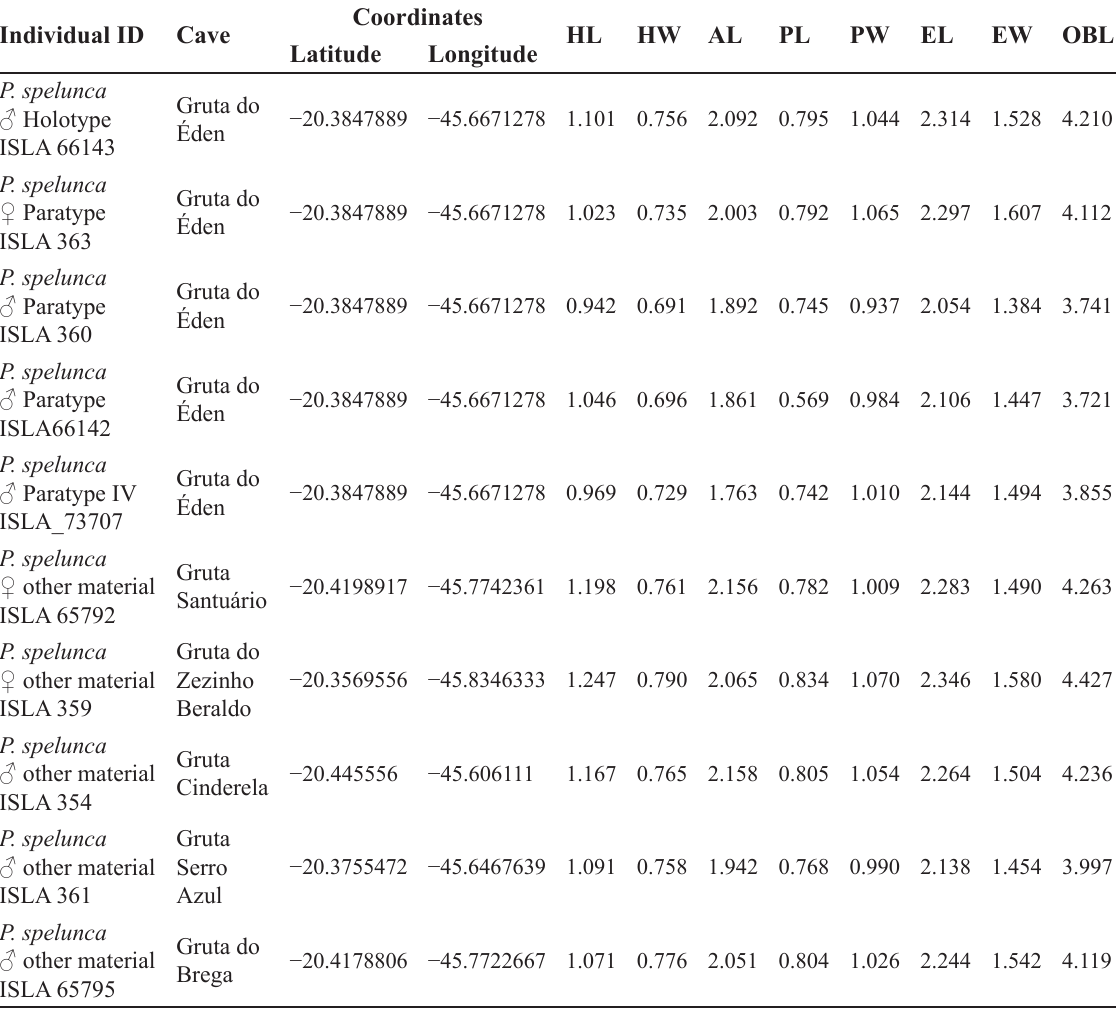
Table 1. Occurrences and body measurements of the new species Perigona spelunca sp. nov. individuals. Measurements are given in